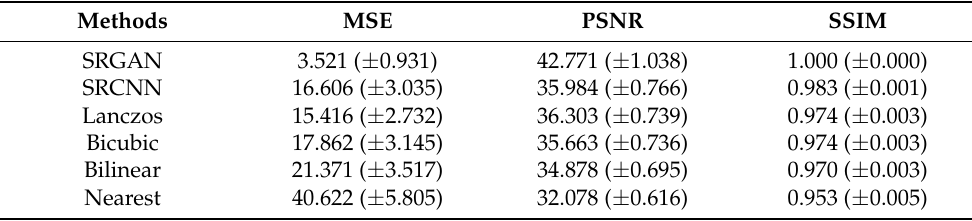
Table 3. Average and standard deviation of mean square error (MSE), peak signal-to-noise ratio (PSNR), and structural similarity index (SSIM) computed for each method.